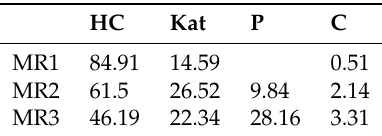
Table 3. Rietveld refinement of the molar calcium-to-aluminium series of LDHs MR1 = 3:2, MR2 = 4:2 and MR3 = 6:2. HC indicates the phase [Ca 4 Al 2 (OH) 12 ][(CO 3 ) · 5H 2 O], Kat is katoite, P is portlandite and C is calcite. All values are given in percentages of the crystalline